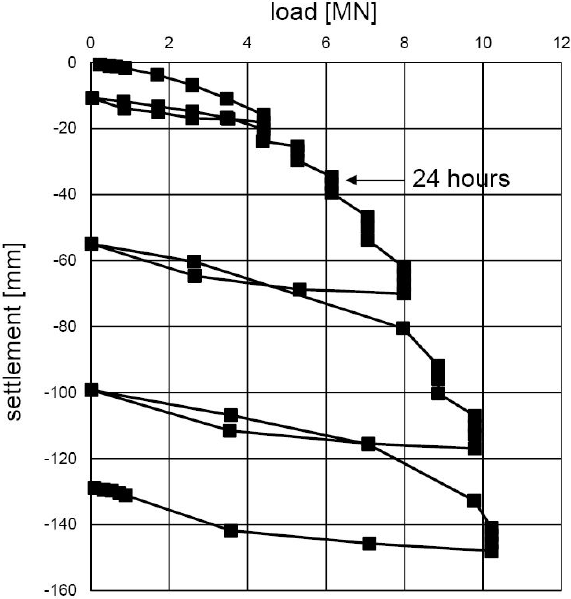
Figure 4: Results of the shallow foundation load test on dense sand after Briaud and Gibbens [8].